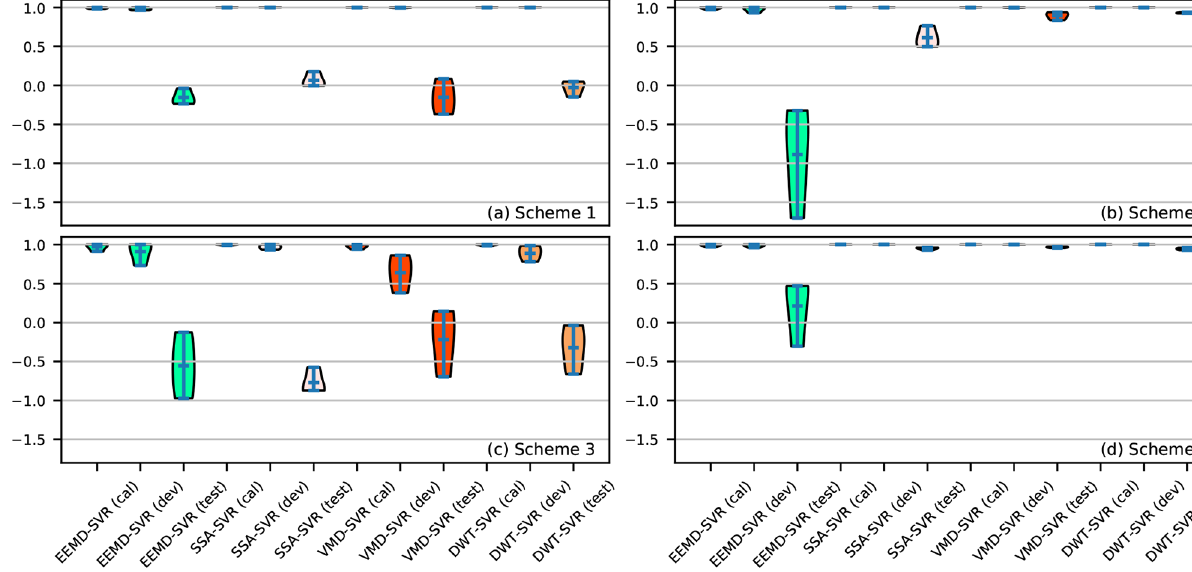
Figure 16. Violin plots of the NSE criterion for TSDP models and 1-month-ahead runoff forecasting (see Fig. 8 for the details of each